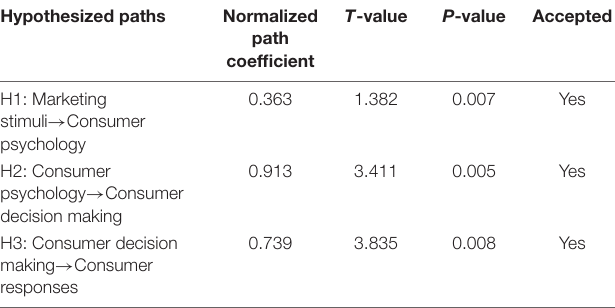
TABLE 6 | Test results of the